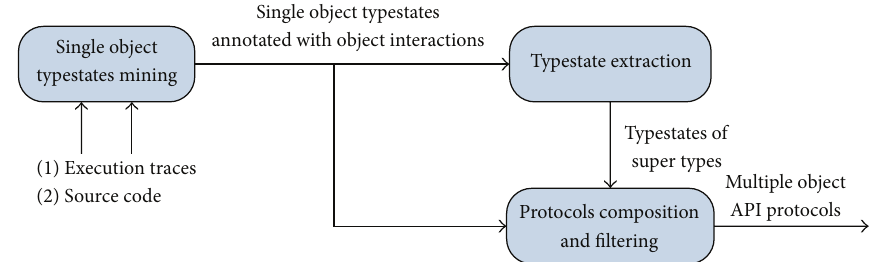
Figure 2: The architecture of our